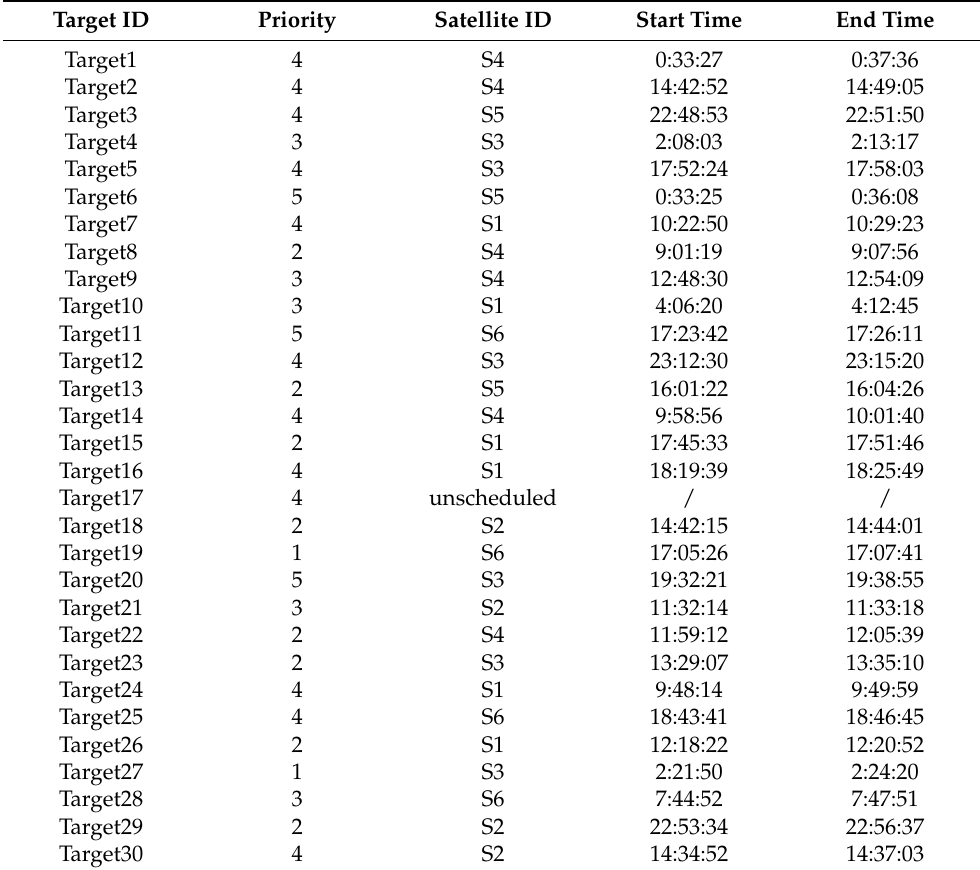
Table 7. Initial scheduling